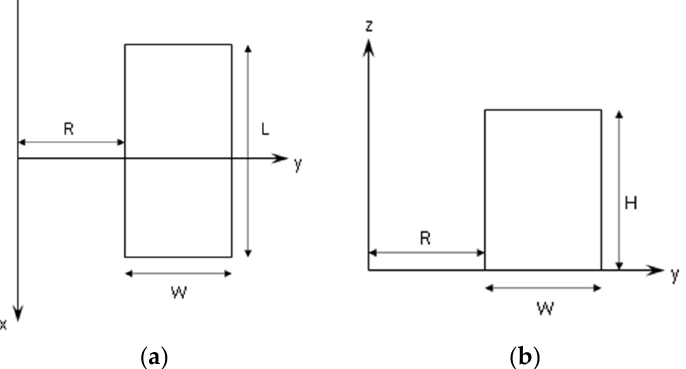
Figure 3. ( a ) Horizontal and ( b ) vertical cross-section of the configuration depicted in Figure